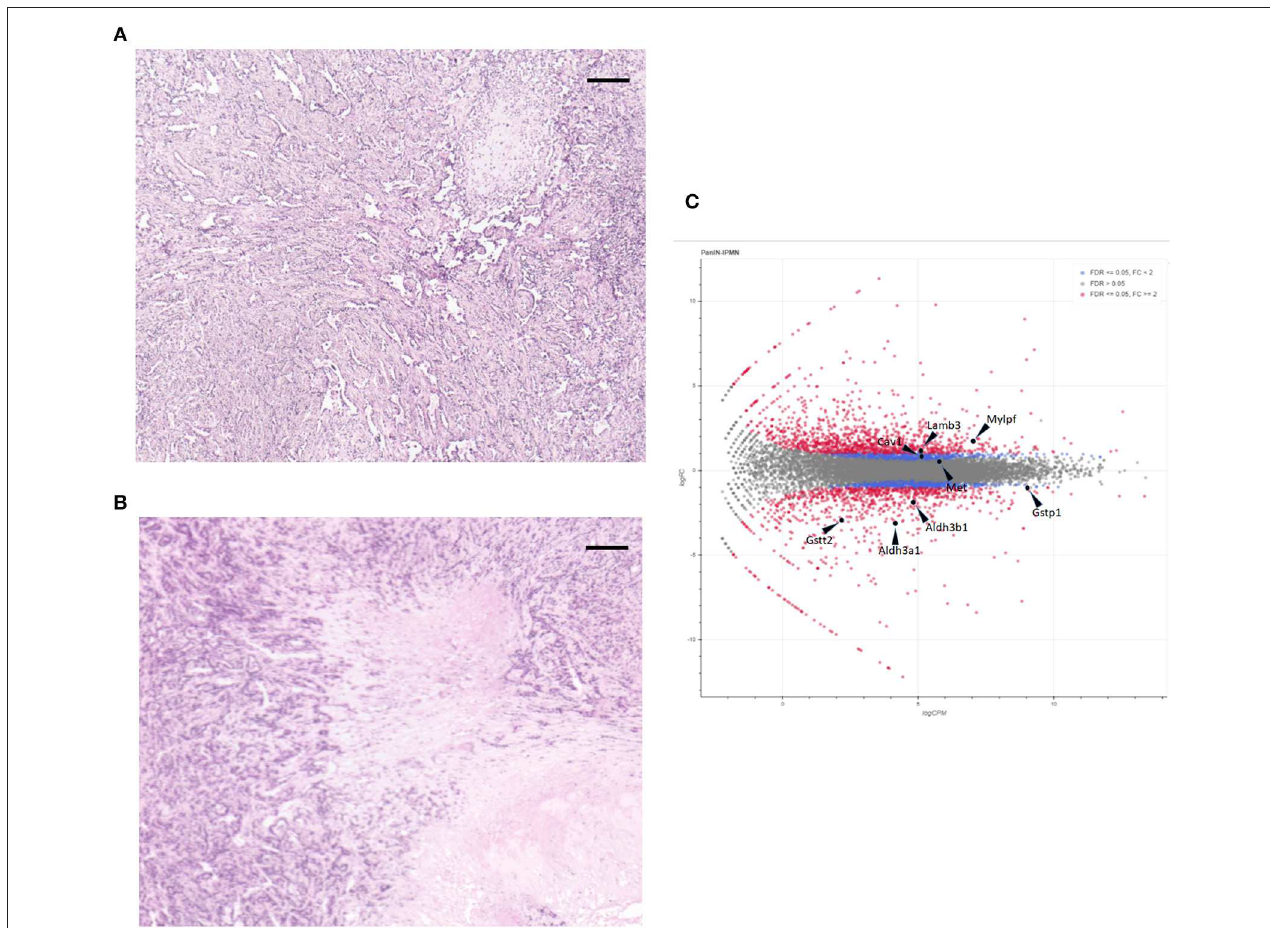
FIGURE 1 | Hematoxylin and eosin staining of subcutaneous tumors formed by cell lines intraductal papillary mucinous neoplasm (IPMN) (A) and pancreatic intraepithelial neoplasia (PanIN) (B) . Scale bar: 200 µ m. (C) MA plot of the monitored expressions of individual genes. Non-differentially expressed (gray dots), differentially expressed (red dots), and the eight selected genes are